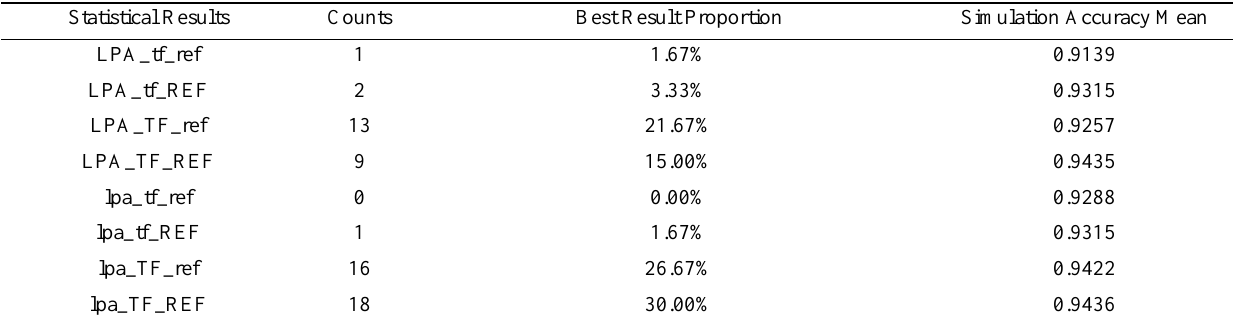
Table 7. Comprehensive comparison of all impact